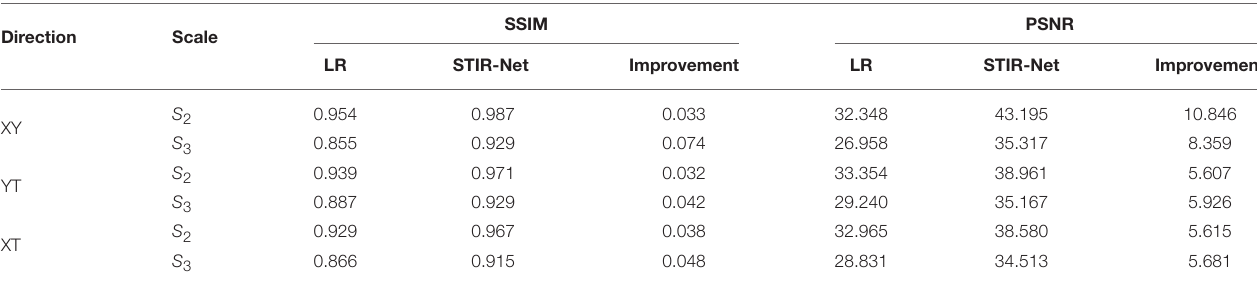
TABLE 1 | Average SSIM and PSNR (dB) performance of seven patients’ 833 CTP slices between different sampling scales for STIR-Net image super-resolution at different spatio-temporal cross-sections. SSIM PSNR Direction Scale LR STIR-Net Improvement LR STIR-Net Improvement